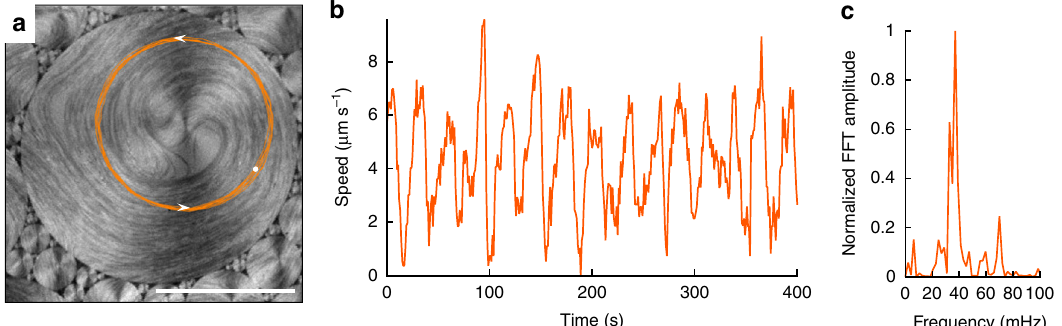
Fig. 6 Oscillations of the swirl speed. a Confocal re fl ection micrograph with the trajectory of a particle adsorbed at the water/LC interface that is being advected by the active fl ow (Supplementary Movie 6). b Instantaneous speed of the tracer in ( a ). c Power spectrum of the data in ( b ). Scale bar 50 μ